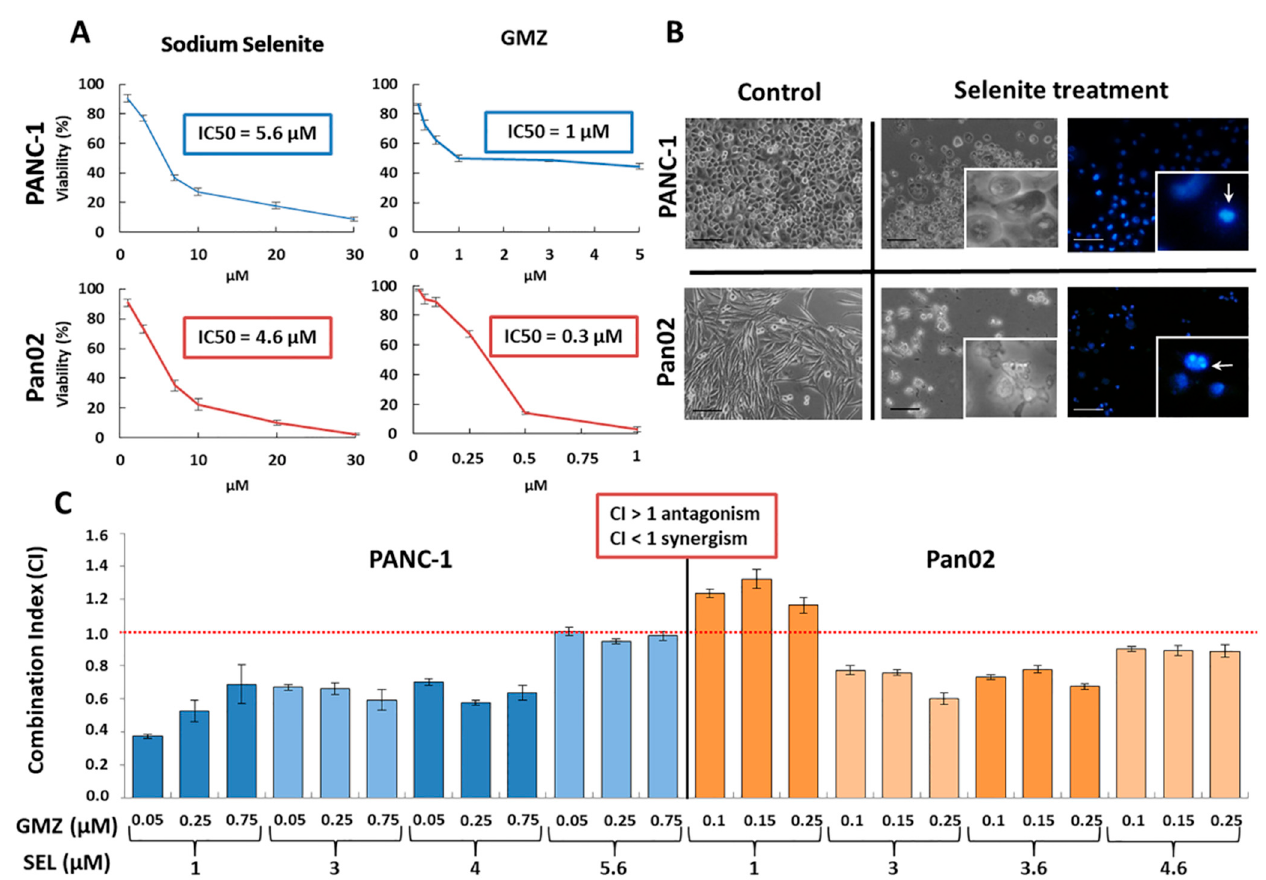
Figure 1. Effect of sodium selenite on pancreatic cancer cells. ( A ) Cell viability graphs and IC50 values of sodium selenite and GMZ in PANC-1 and Pan02 cells. Cells were exposed to sodium selenite and GMZ at different doses for 72 h. ( B ) Morphological changes in PANC-1 and Pan02 cells after exposure to sodium selenite (magnification 10×; detail magnification 15×). Hoestch staining showed nuclear fragmentations (arrows) indicating the presence of apoptotic bodies (apoptotic-like cell death). ( C ) Combination index (CI) of sodium selenite and GMZ in PANC-1 and Pan02 cells (CI > 1, antagonism; CI < 1, synergism). GMZ (gemcitabine); SEL (sodium selenite).